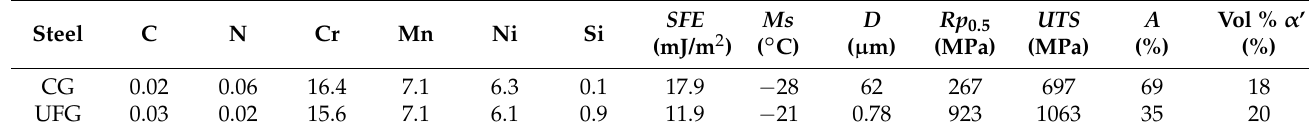
Table 1. Chemical composition and mechanical properties of CG and UFG material conditions (Fe balance). In addition, M s , SFE, area-weighted average grain size D and martensite content after tensile testing are provided.